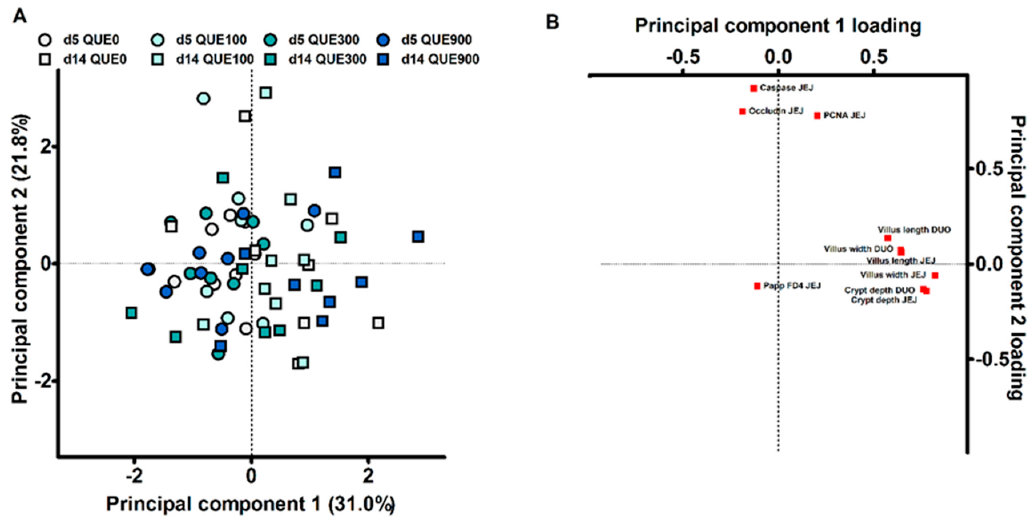
Figure 6. Principal component analysis of gut health parameters in the duodenum and distal jejunum of piglets at d5 and d14 post-weaning (DAY), fed a diet containing either 0, 100, 300, or 900 mg quercetin / kg diet (QUE) during the first 14d post-weaning: ( A ) Scores plot representing the 64 individual piglets in the multivariate space of the first two principal components. Animals can be visually clustered according to day post-weaning (d5 or d14). ( B ) Loading plot of the two major principal components. DUO = duodenum; JEJ = distal jejunum; PCNA = proliferating cell nuclear antigen; Papp = apparent permeability coe ffi cient; FD4 = fluorescein isothiocyanate